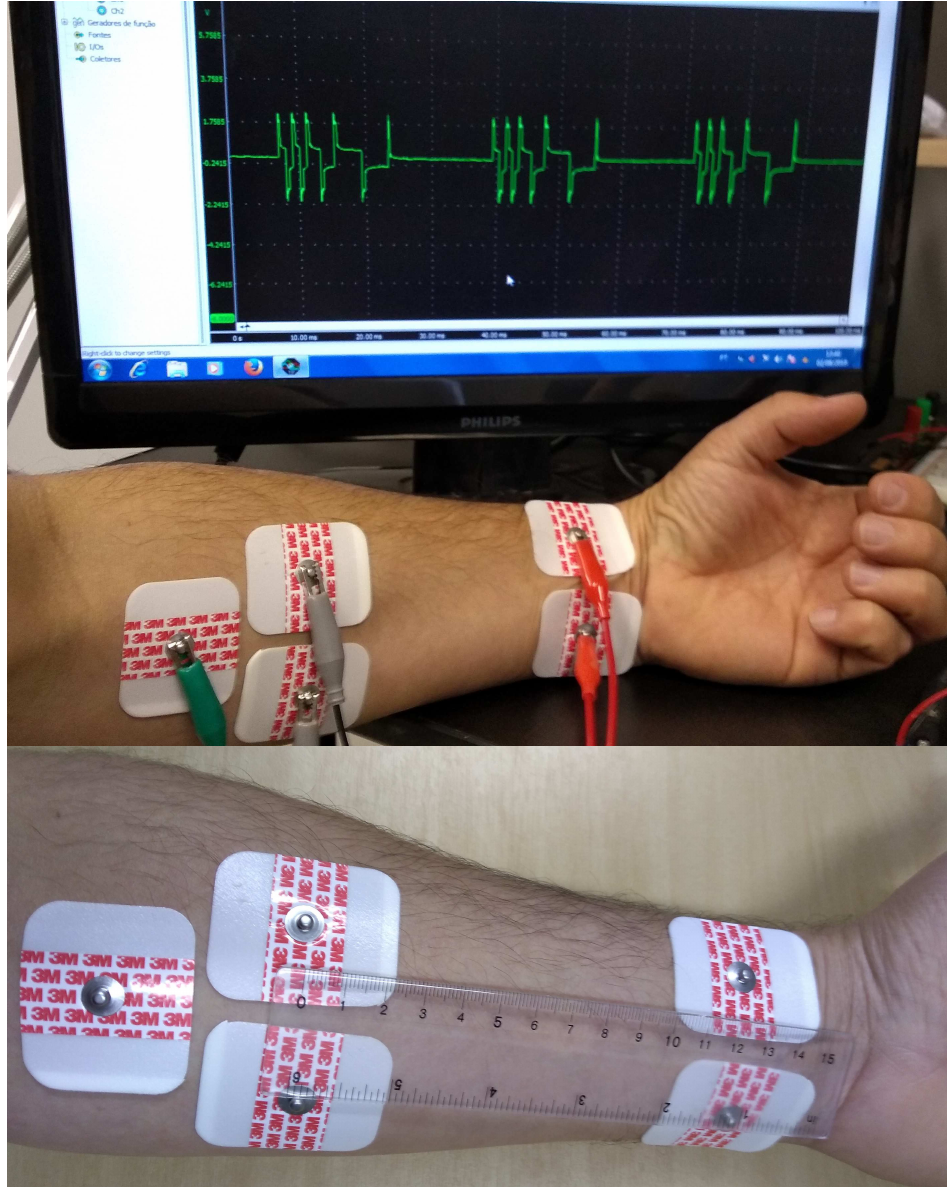
Figure 5. Battery-powered coupling system connected to the forearm using disposable